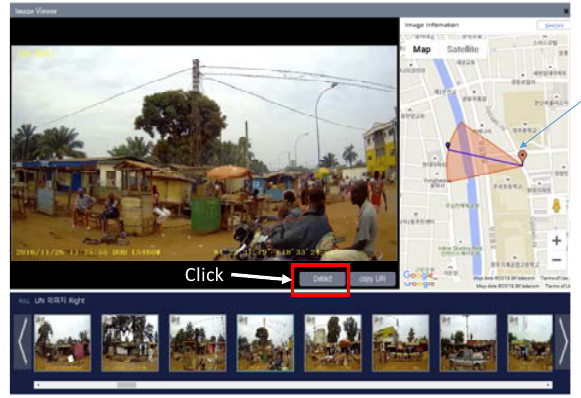
Figure 6. Object detection by deep learning model in a geo-tagged media